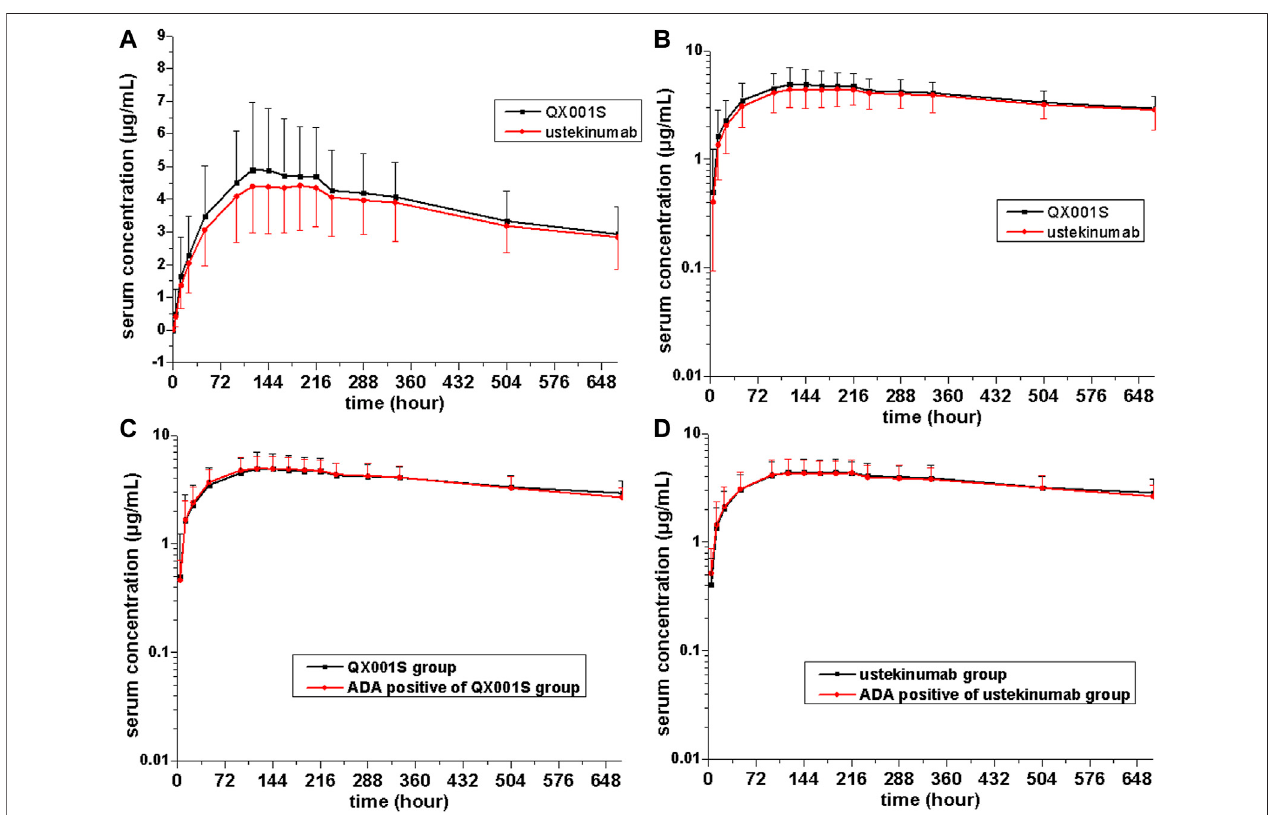
FIGURE 3 | Serum drug concentration-time pro fi les for ustekinumab and its biosimilar for 0 – 672 h after dosing. Mean ± standard deviation values (A) ; log10 mean ± standard deviation values (B) ; Mean ± standard deviation values for ADA-positive and total individuals in the QX001S (C) and ustekinumab (D) groups.